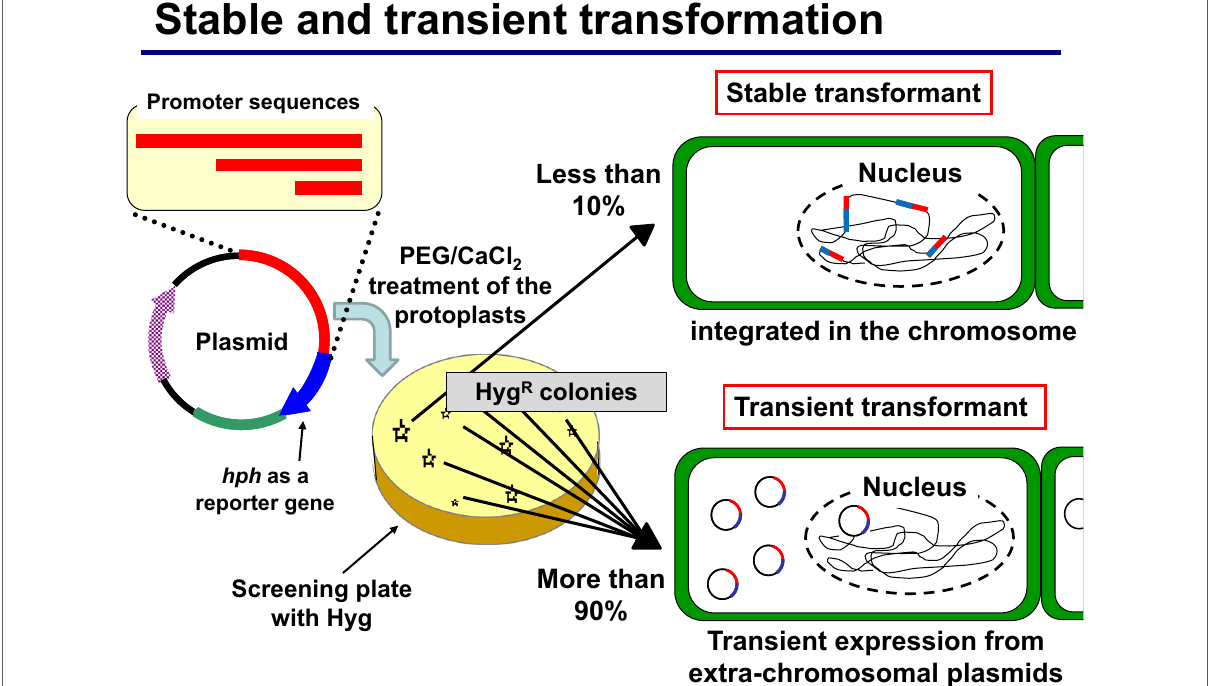
Fig. 6 Schematic representation of stable and transient transformation. Introduced recombinant hph plasmids confer hygromycin resistance by direction of its promoter sequence. Transient transformants may express hph extrachromosomally and lose the plasmid during repeated transfer on the fresh screening